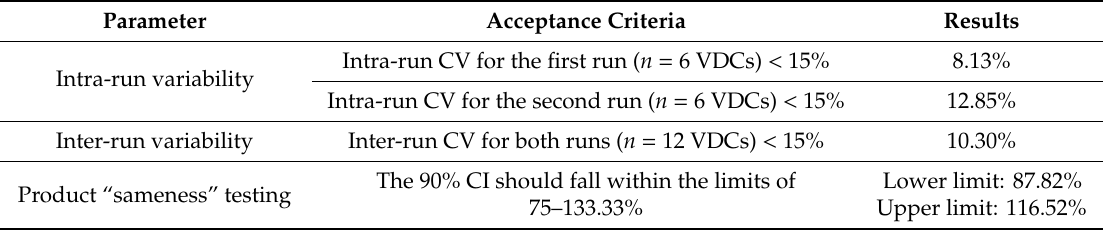
Table 3. Predefined acceptance criteria and results of the performance verification test (PVT).